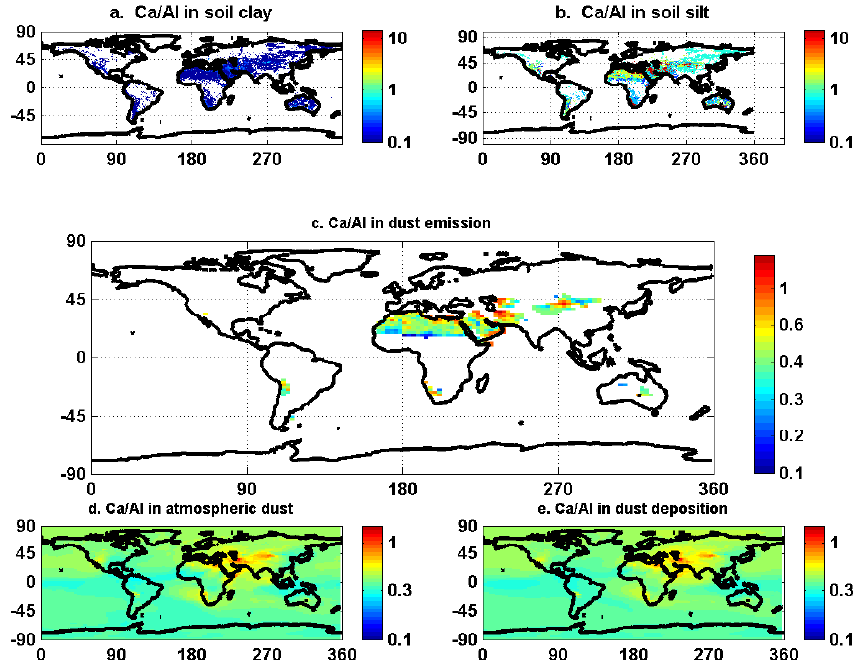
Figure 8. Ca / Al in soil and 10-year-averaged Ca / Al ratio in dust emission, concentration and deposition. Top two (a, b) refer to ratio in clay and silt desert soil, middle one (c) refers to ratio in dust emission, and bottom two (d, e) refer to ratio in dust concentration and deposition. Elemental annual mean percentages are calculated using the annual mean emission of each element divided by the annual mean emission of dust.